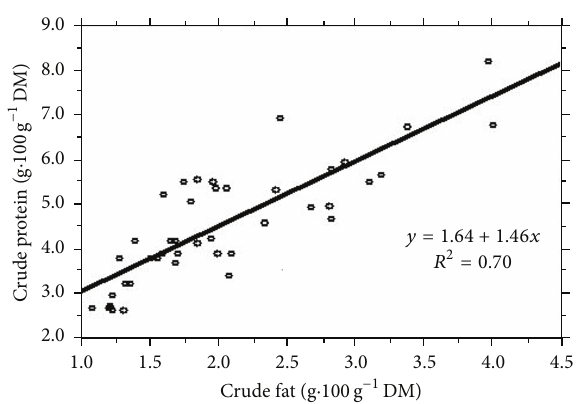
Figure 1: Correlation ( 𝑝 < 0.05 ) between the content of crude fat and crude protein (g ⋅ 100 g −1 DM) in four blueberry cultivars in three harvest